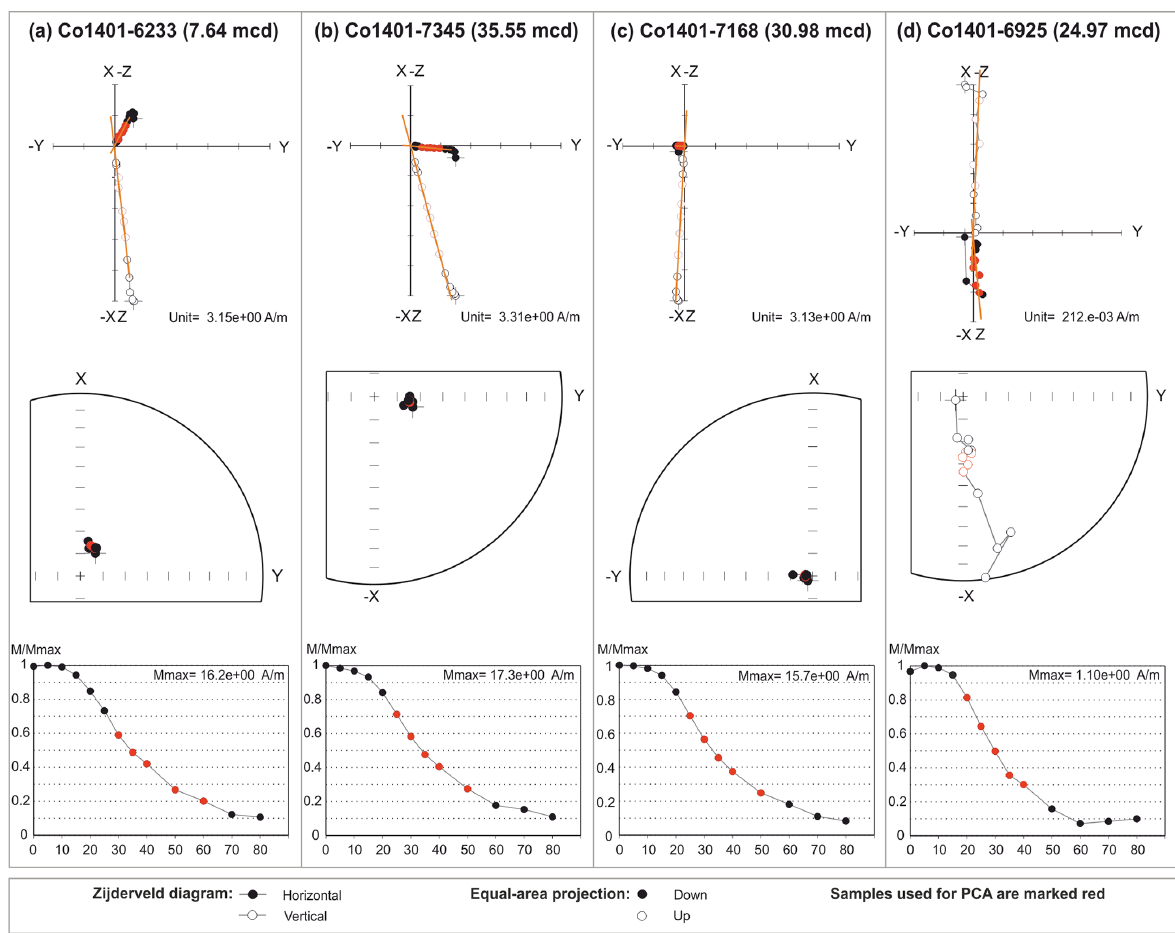
Figure 4. AF demagnetization characteristics of selected samples. Zijderveld diagrams, equal area projections, and normalized NRM inten- sity are shown in the first, second, and third row, respectively. Points used to define the ChRM are marked in